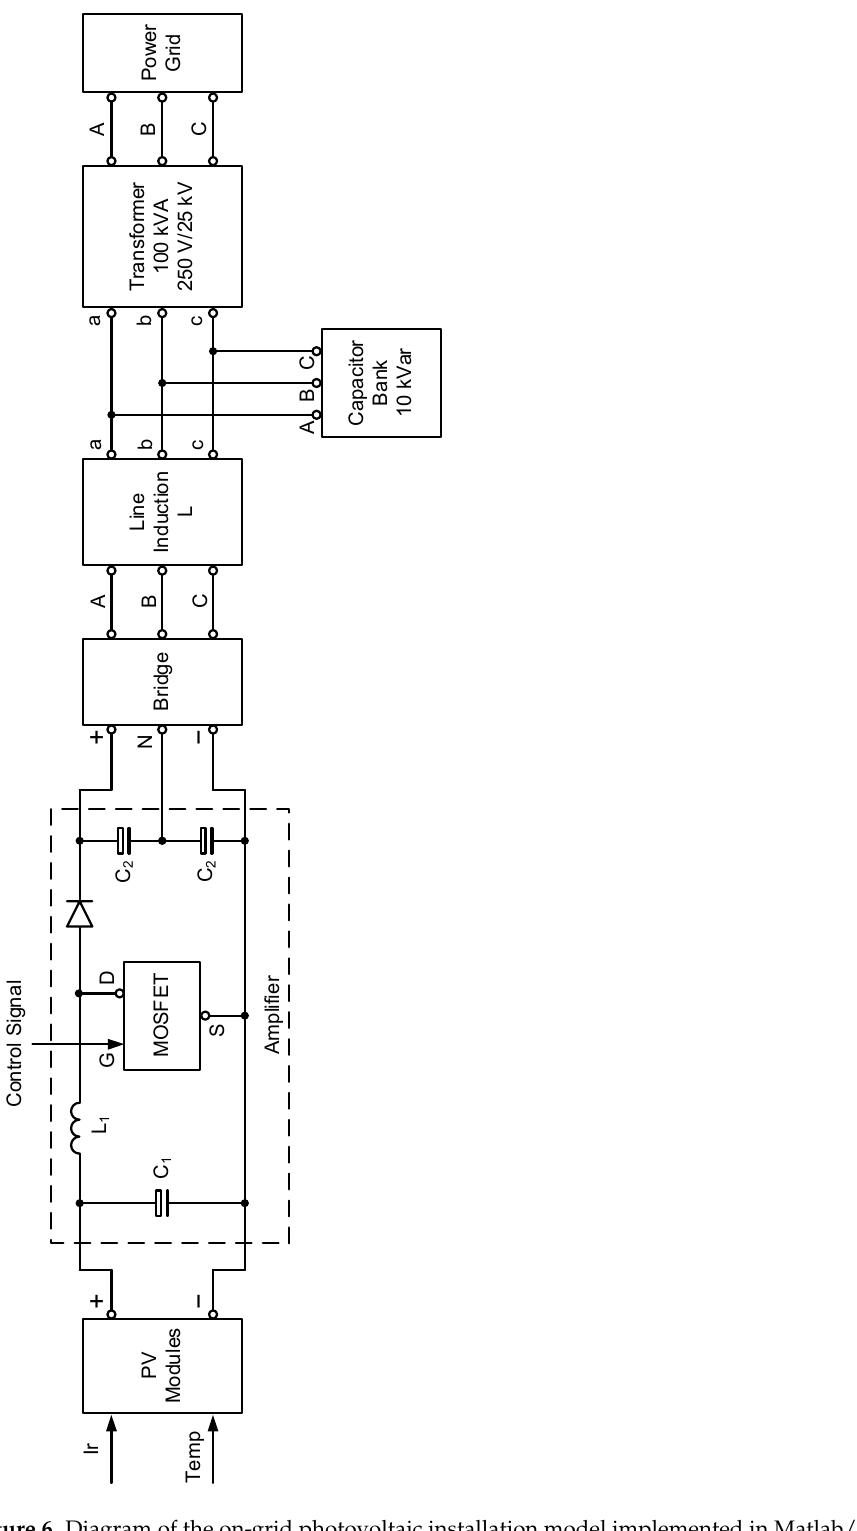
Figure 6. Diagram of the on-grid photovoltaic installation model implemented in Matlab/Sim- ulink.